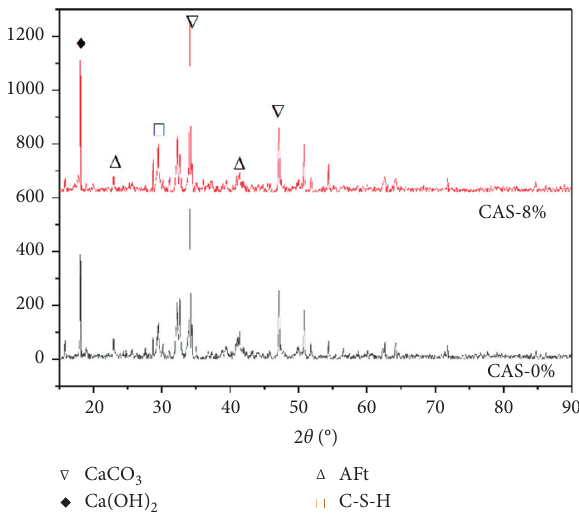
Figure 13: XRD component